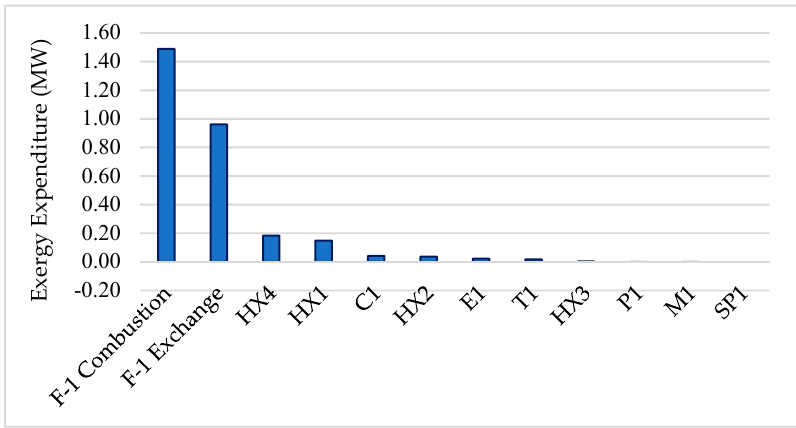
Table 4. Exergy balance for case 1.